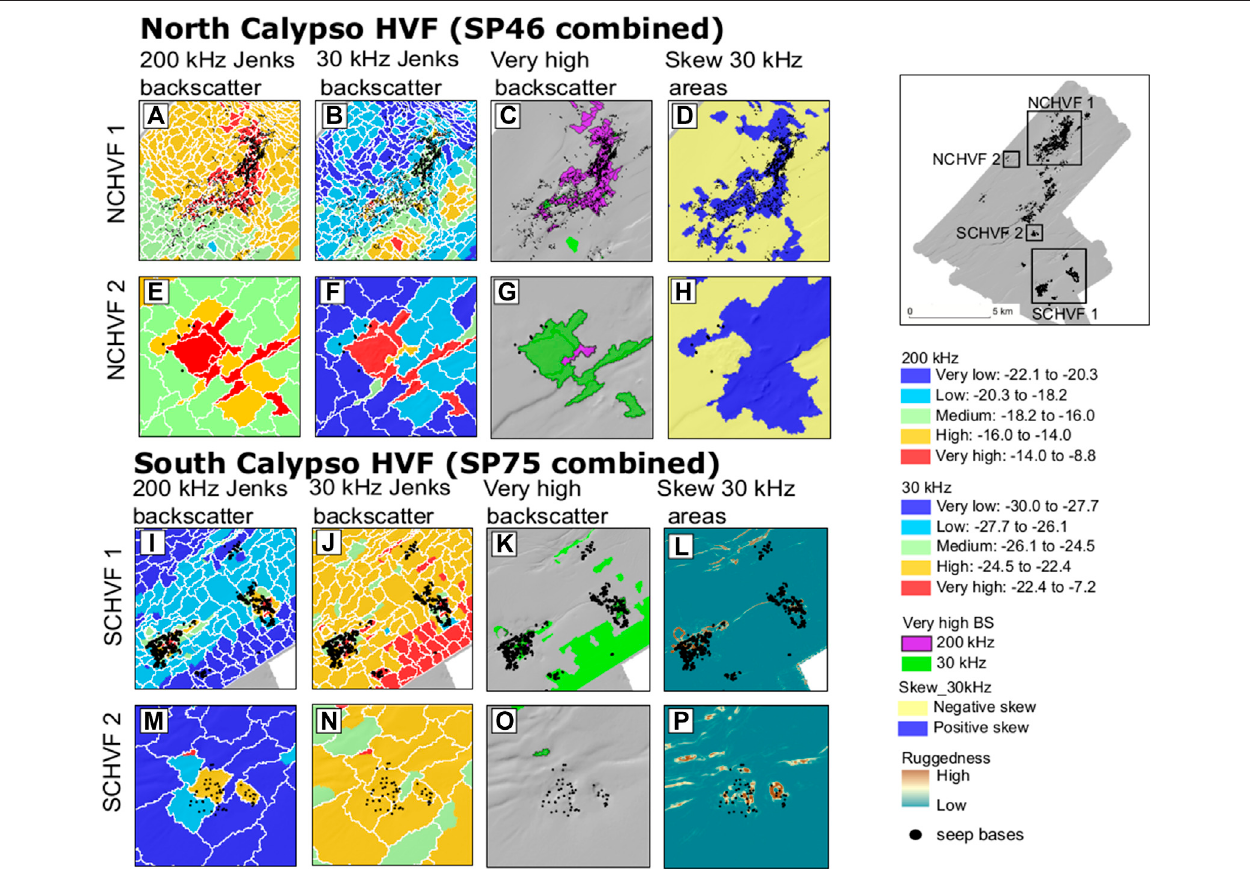
FIGURE6 | Seeps(blackdots),segmentation(whitelines),andJenksNaturalBreaksre-classi fi cationofsegments(colours)basedondistributionofmeanbackscatter levels.Rownamesrefertolocationoninsetmap.Firsttworows (A-H) showNorthCalypsoHVFsubsetsofthesegmentationwithSP46(thebestperformingNCHVFmodel); bottomtworows (I-P) showSouthCalypsoHVFsubsetsofthesegmentationwithSP75(thebestperformingSCHVFmodel).Firstcolumn (A,E,I,M) showsJenksclassesof mean 200 kHz backscatter values. Second column (B,F,J,N) shows segment Jenks classes of mean 30 kHz backscatter values. Third column (C,G,K,O) shows comparison of very-high backscatter segments of the 200 kHz (purple with black outline) and 30 kHz (green) segments, with other segments removed. Green (30 kHz) segments with a dark outline are overprinted 200 kHz very-high segments. Top of fourth column (D,H) show segments with mean negative (cream segments) and positive (navy segments) skew of the 30 kHz mosaic, the most important variable in the North Calypso HVF best performing model. Bottom of fourth column (L,P) show the vector ruggedness measure (rugosity) bathymetric derivative layer, overlain by seeps, the most important variable in the South Calypso HVF best performing model.